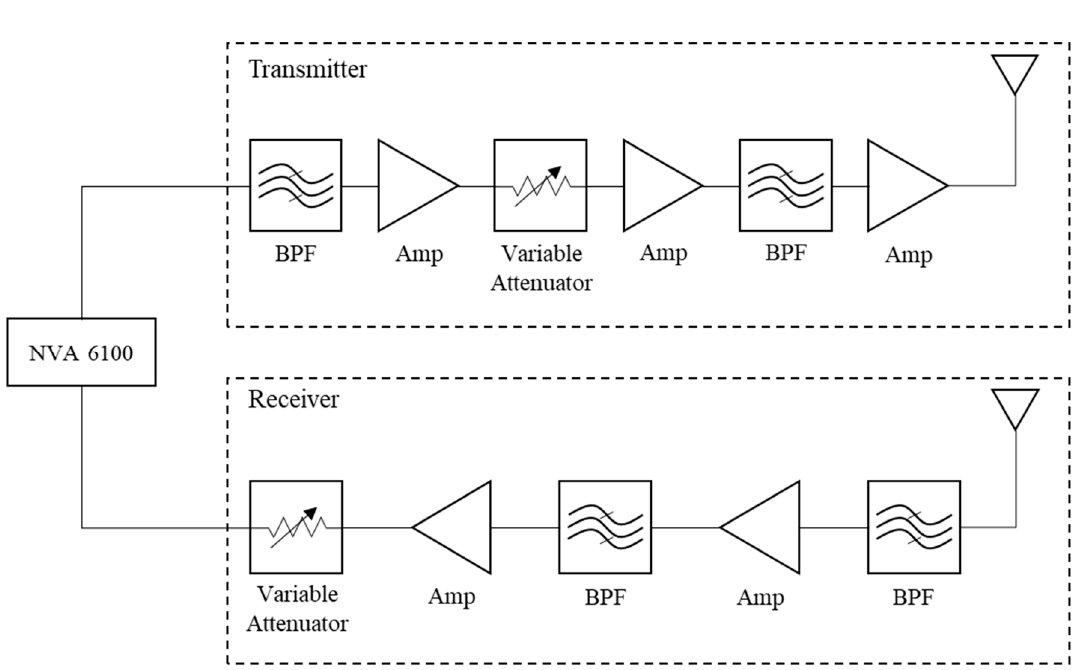
Figure 1. Ultra-wide band radar module. Table 1. NVA6100 Specifications.